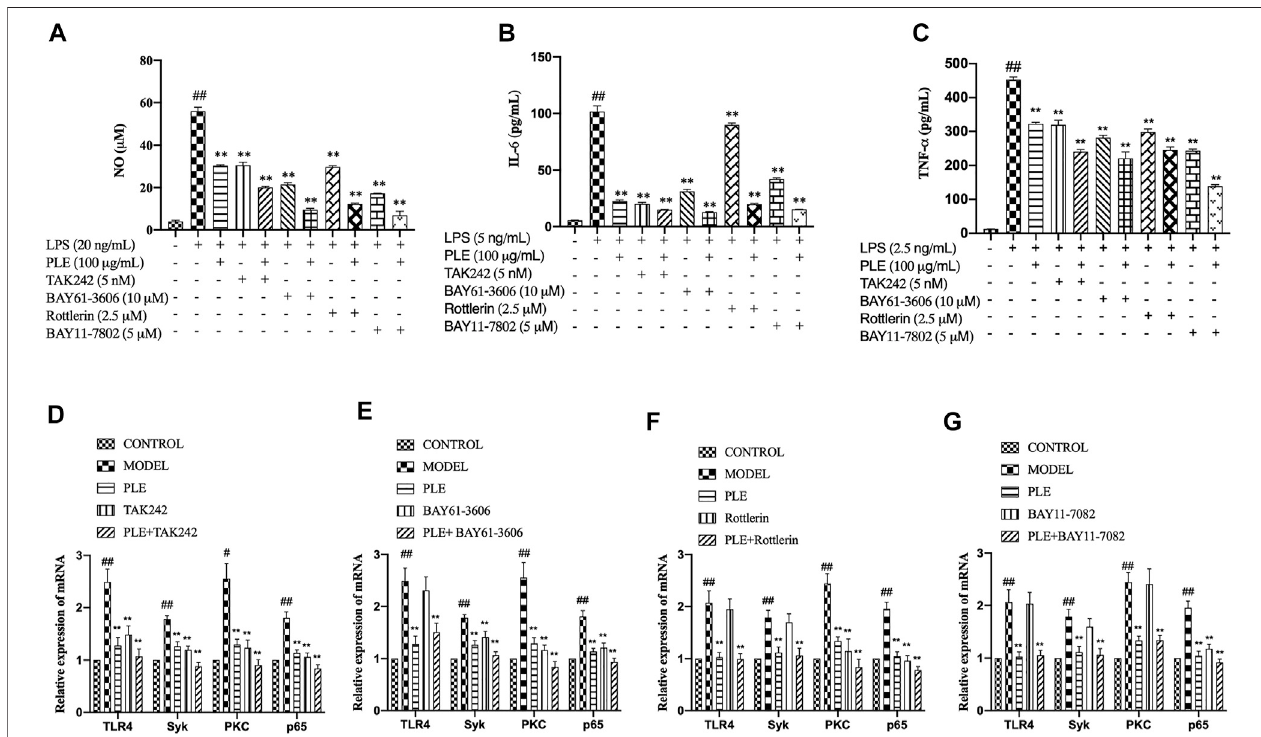
FIGURE 6 | Veri fi cation that TLR4/Syk/PKC/NF- κ B p65 were associated with PLE anti-in fl ammatory activity in vitro . Levels of NO (A) were detected by Griess assay,andthoseofIL-6 (B) andTNF- α (C) byELISAassay.ThemRNAexpressionofTLR4 (D) ,Syk (E) ,PKC (F) ,andNF- κ Bp65 (G) weredetectedbyqRT-PCR(n (cid:2) 3). Data were shown as mean ± SEM. # p < 0.05 and ## p < 0.01 compared with the CONTROL group; * p < 0.05 and ** p < 0.01 compared with the MODEL